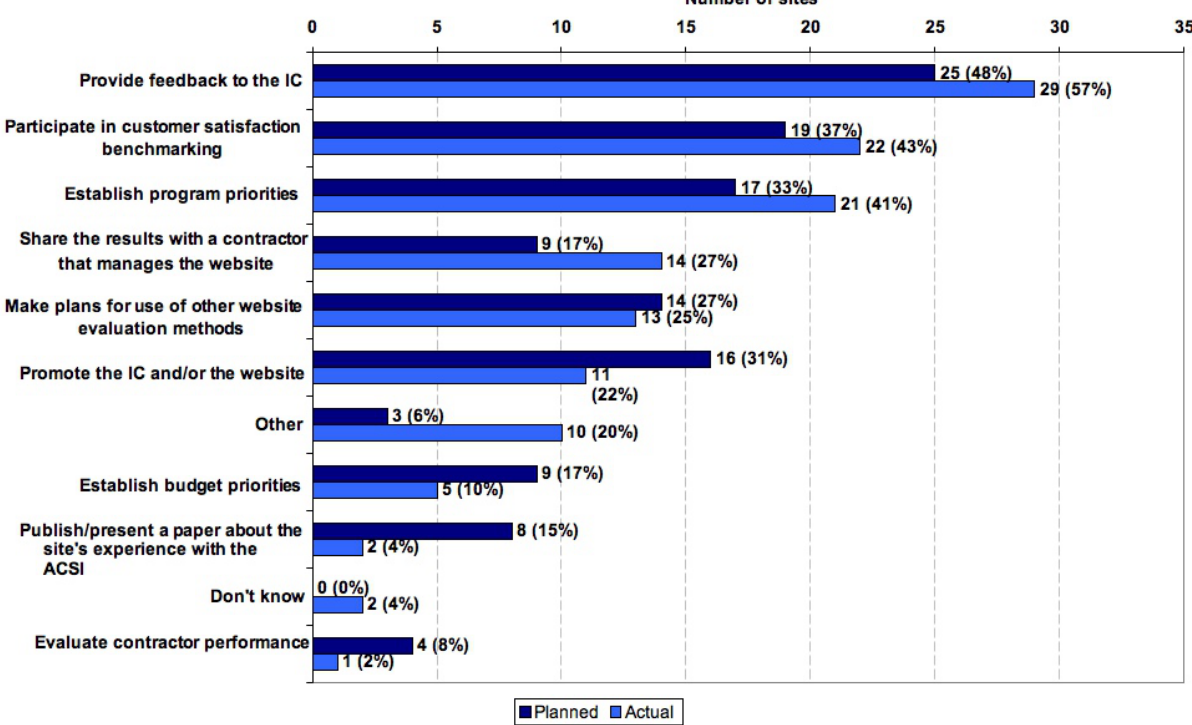
Figure 2. Use of ACSI survey data as reported by participating NIH website teams (Method: Initial Website staff survey, n=52, and final Website staff survey,